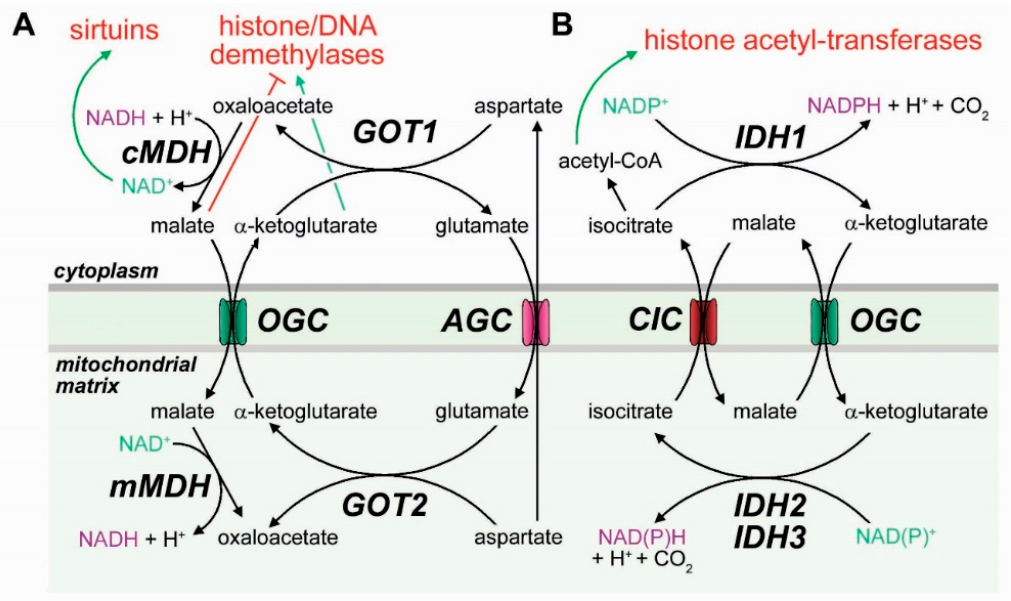
Figure 3. Mitochondrial shuttle systems are essential for the mitochondrial metabolic signaling to the nucleus. ( A ) The malate-aspartate shuttle involves cycling of α KG / malate and glutamate / aspartate between the cytoplasm and the mitochondria, with a net movement of reducing equivalents from the cytoplasm to the mitochondrial matrix in the form of NADH. The increased cytoplasmic NAD + produced by the net activity of the shuttle can activate the NAD + -dependent deacetylases (HDACs) of the sirtuin family. The exchange of α KG for malate can increase the activity of histone and DNA demethylases. ( B ) The citrate- α KG shuttle involves cycling of citrate / isocitrate, malate, and α KG between the cytoplasm and the mitochondria, with a net movement of reducing equivalents from the mitochondrial matrix to the cytoplasm in the form of NADPH. The isocitrate exported by the CIC can also be converted in the cytosol to acetyl-CoA, which acts as a substrate for histone deacetylases. The balance between di ff erent mitochondrial export systems determines the metabolic signaling sent to the nucleus in response to metabolic cues.